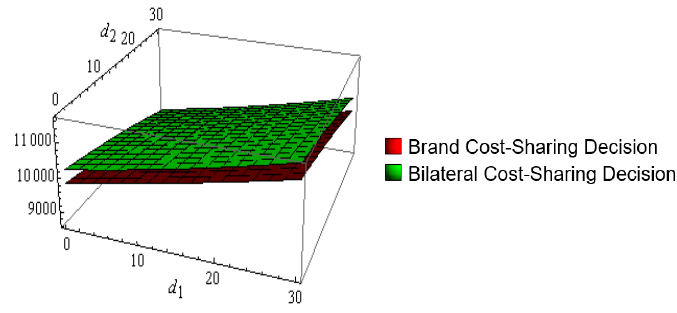
Figure 4. Im pact of Time Delay on the Retailer’s Profit. Figure 4. Impact of Time Delay on the Retailer’s